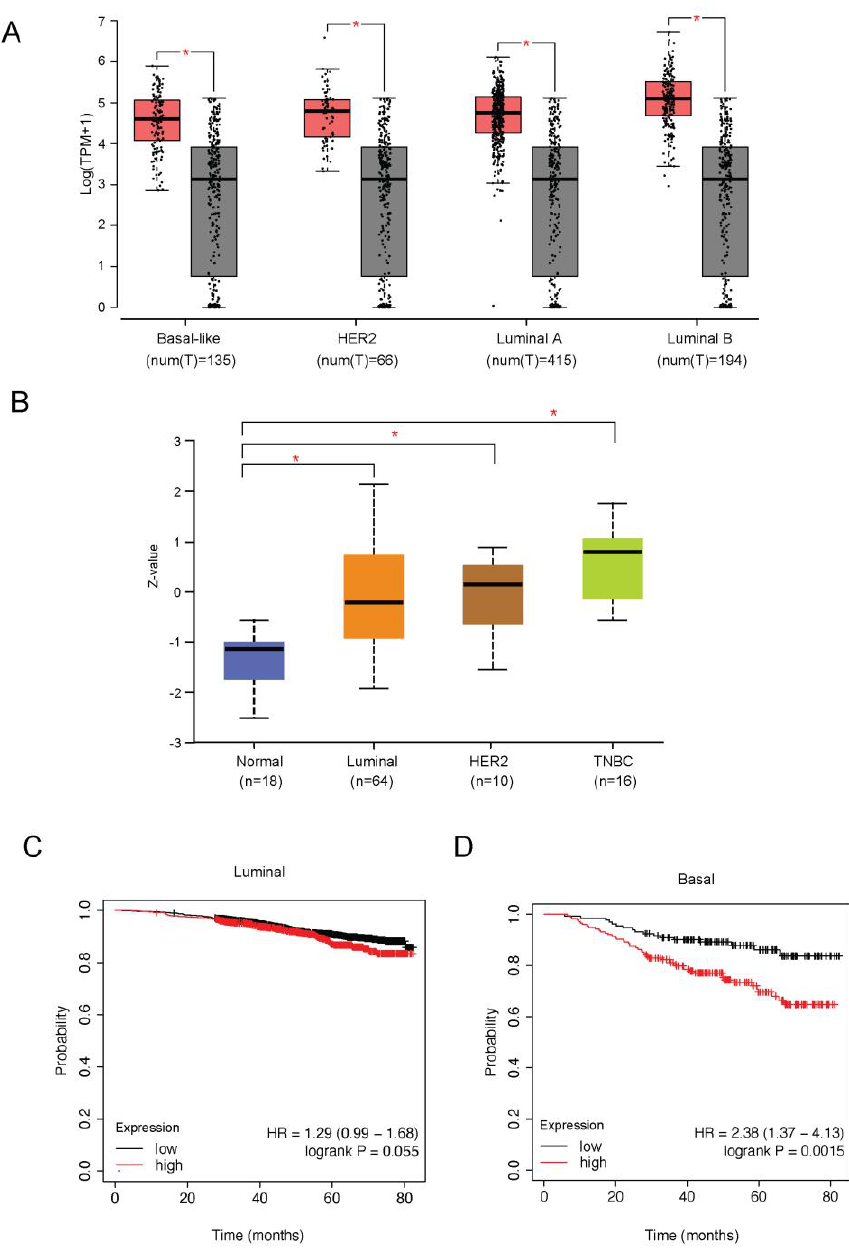
Figure 1. GRHL2 expression in breast cancer. ( A , B ) The expression of GRHL2 mRNA ( A ) and protein ( B ) in different subtypes of breast cancer based on analyzing data from TCGA, GTEx, and CPATC databases. TPM, transcripts per million. * Indicates p < 0.01. Red and gray blocks in ( A ) represent tumor and normal samples, respectively. Dots show full distribution of all samples in the given group. ( C , D ) Association of GRHL2 expression with overall survival based on analyzing data from KM plotter